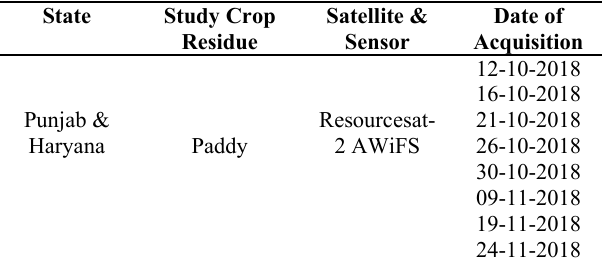
Table 1.IRS Satellite data used in crop residue burnt area estimation